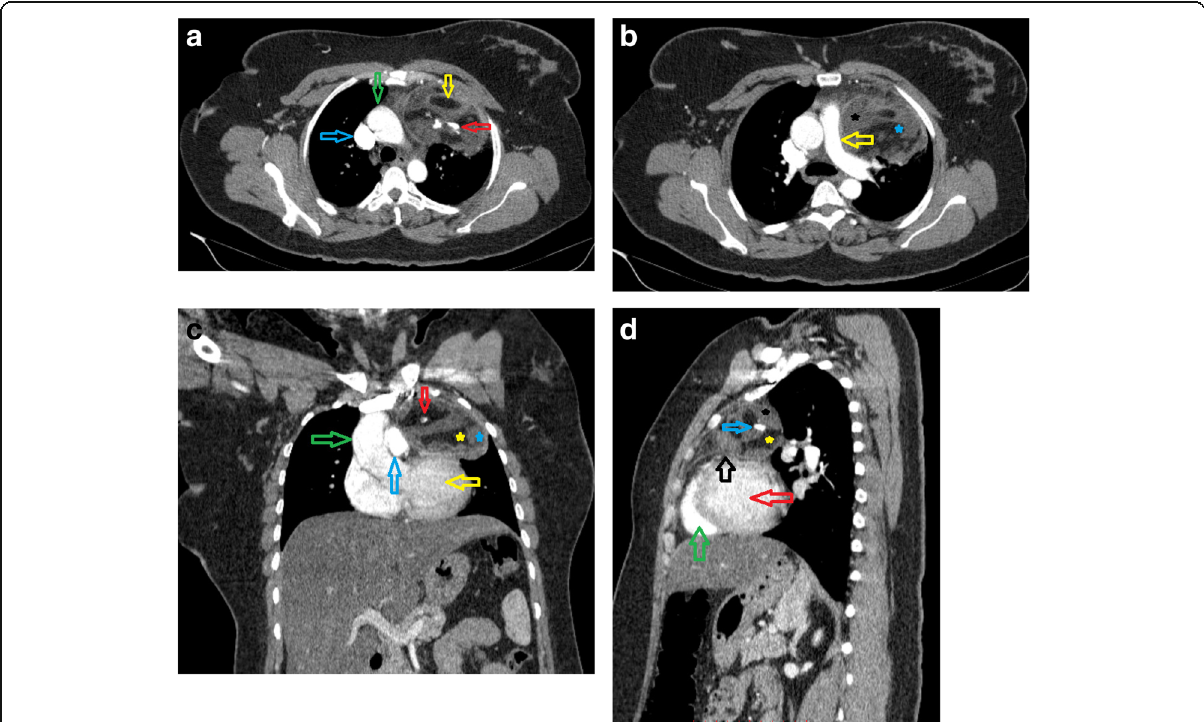
Fig. 2 a , b Axial contrast-enhanced CT scan images show teratoma in the left aspect of the anterior mediastinum. a Fat component (yellow arrow), dense calcification (red arrow), aortic arch (green arrow), and superior vena cava (blue arrow). b Soft tissue and cystic fluid components (black asterisk), fat component (blue arrow), and pulmonary trunk and left pulmonary artery (yellow arrow). c Coronal contrast-enhanced CT scan image shows teratoma. Dense calcification (red arrow), fat component (yellow asterisk), soft tissue component (blue asterisk), left ventricle (yellow arrow), ascending aorta (green arrow), and left pulmonary artery (blue arrow). d Sagittal contrast-enhanced CT scan image shows teratoma in the anterior aspect of the left mediastinum. Fat component (yellow asterisk), dense calcification (blue arrow), soft tissue component (black asterisk), intact pericardium (black arrow), left ventricle (red arrow), and right ventricle (green